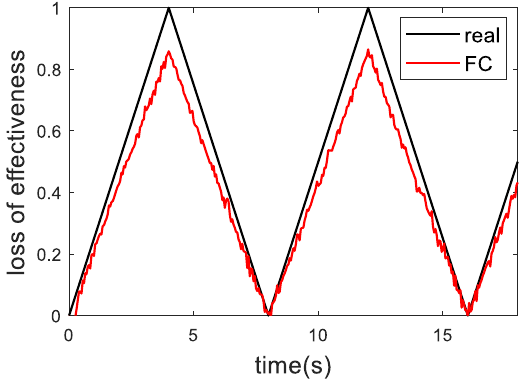
Figure 4. Actuator effectiveness reconstruction result of the observer.